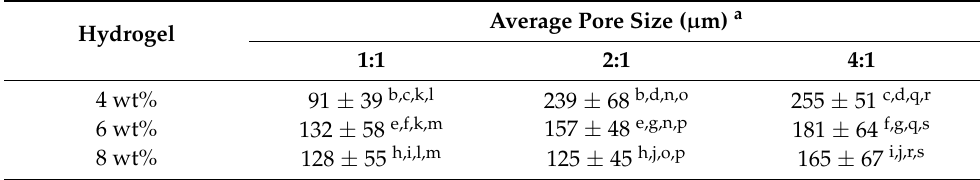
Figure 7. SEM images of the internal morphology of freeze-dried hydrogels. Table 3. Average pore sizes of the P(KA)/4-PEG hydrogels with varying molar ratios and total polymer concentrations .